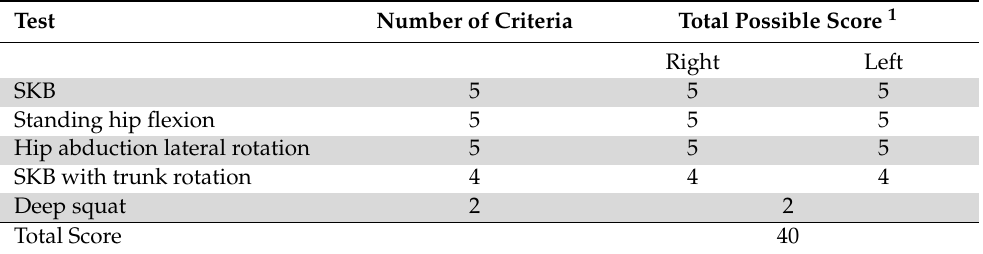
Table 1. The Hip and Lower Limb Movement screen scoring—more details in Booysen et al.’s study [5]. Test Number of Criteria Total Possible Score 1 Right Left 5 5 5 5 5